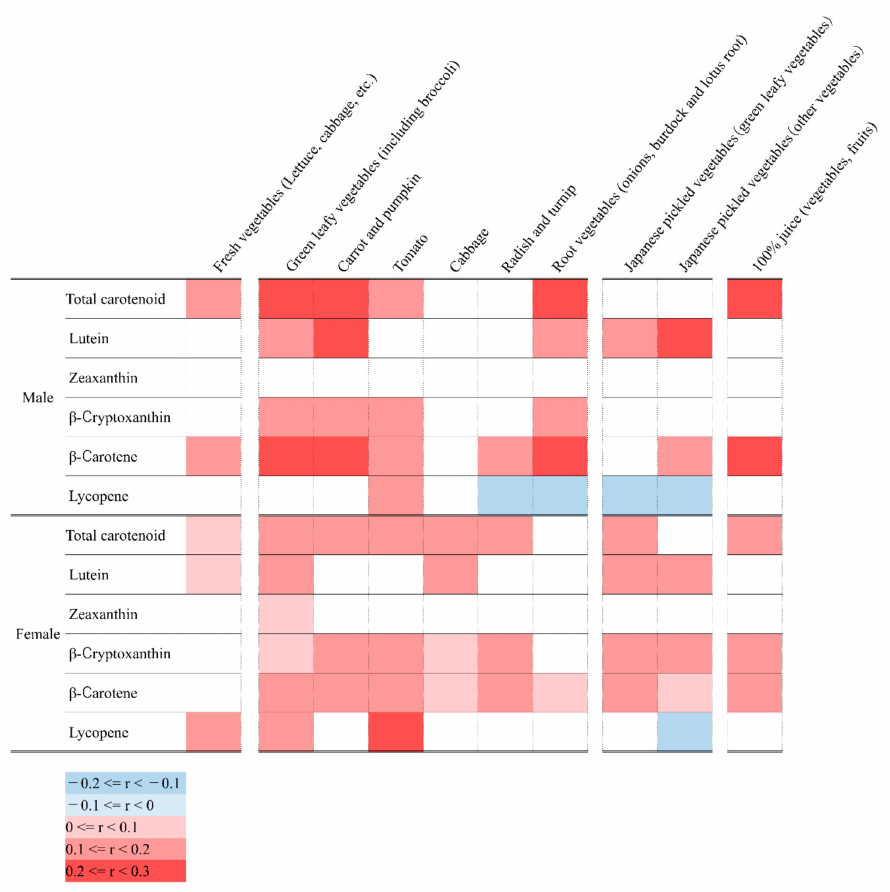
Figure 2. Correlation coefficients between serum carotenoids and consumed